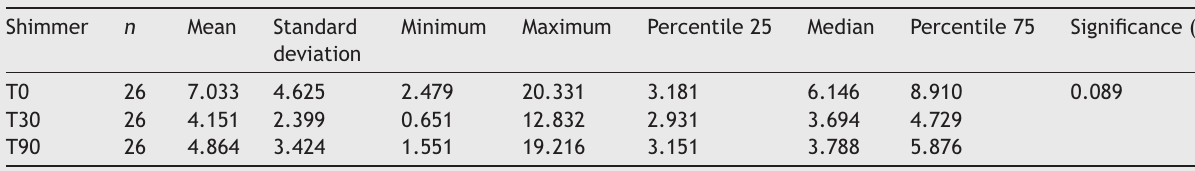
Shimmer --- Vowel /i/.